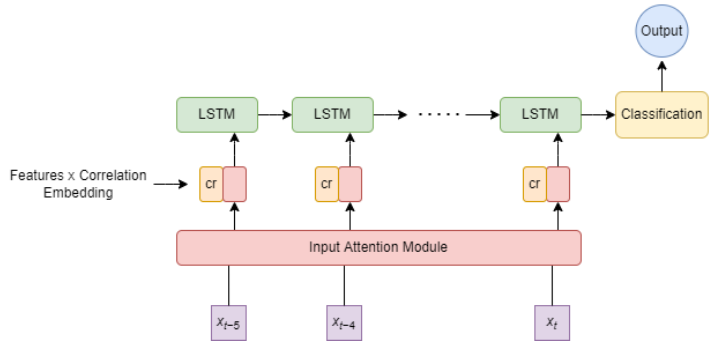
Figure 4. Proposed Multicollinearity Reduction Model Framework.